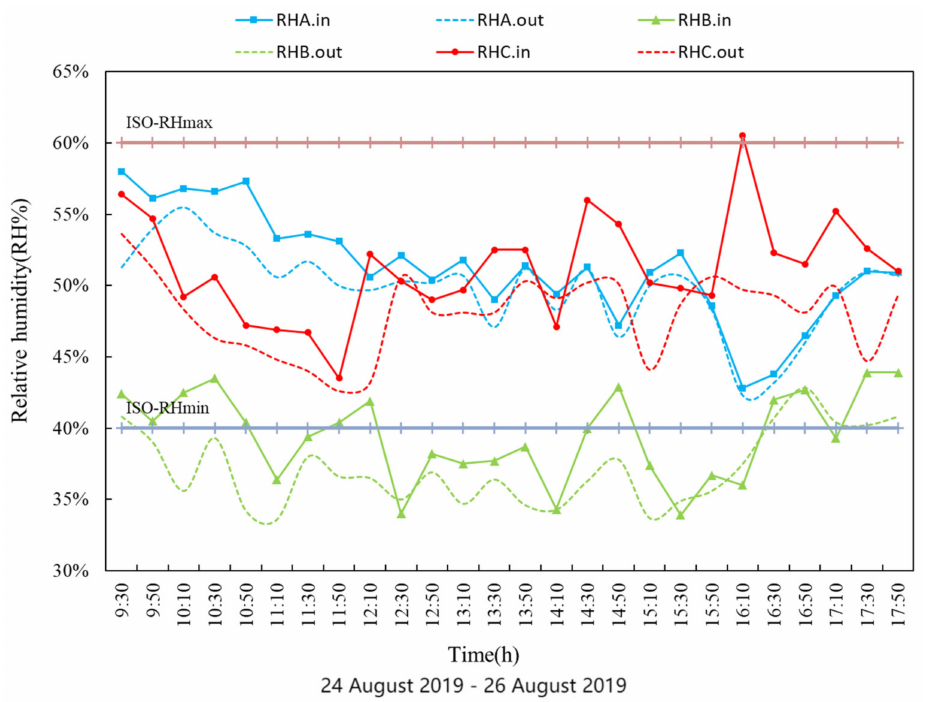
Figure 2. Combination of relative humidity changes in tested